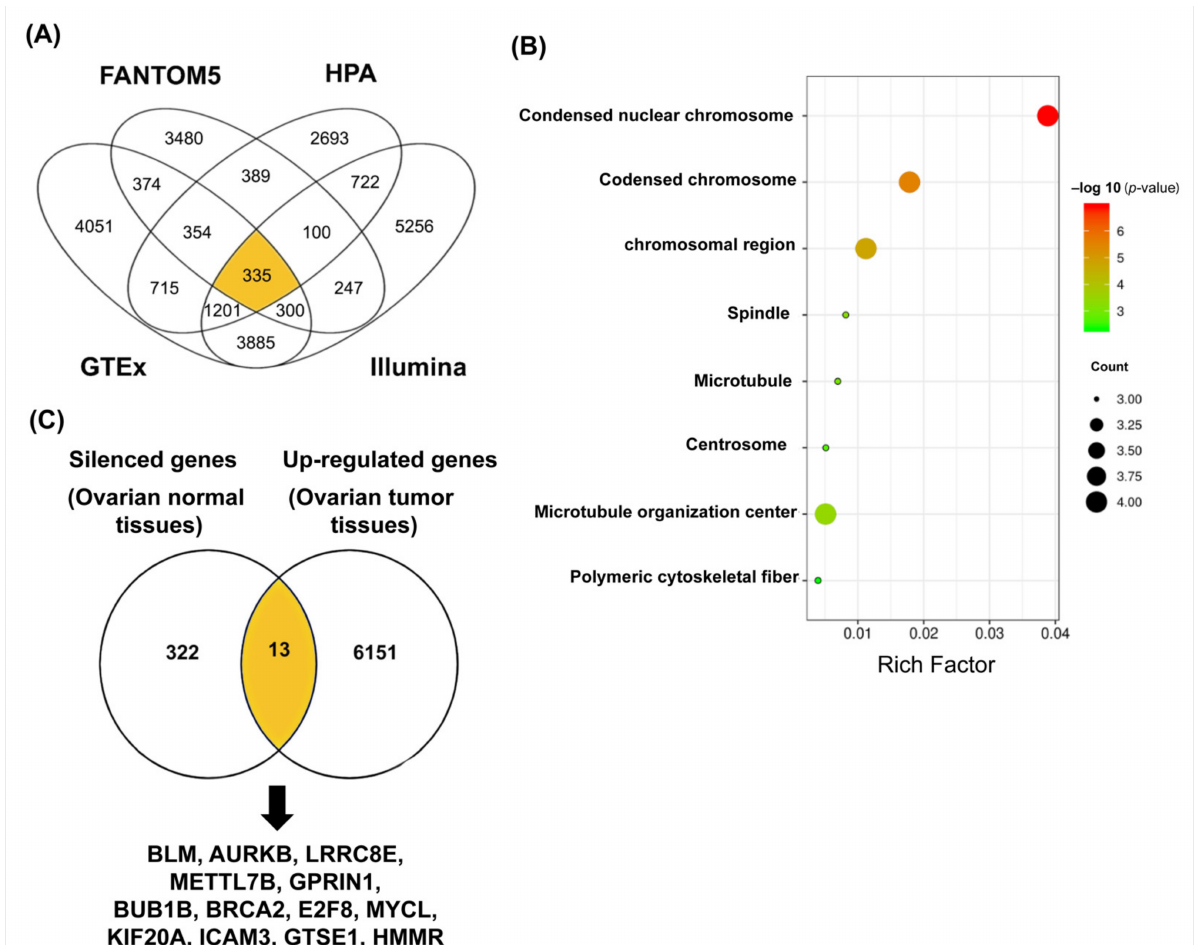
Figure 1. Identification and functional characterization of DEGs in OC. ( A ) Four datasets (FANTOM5, HPA, GTEx, and Illumina Body Map) were used to identify silenced genes in normal ovarian tissues, and the 335 overlap genes were marked by yellow in the middle; ( B ) 335 silenced genes from normal ovarian tissues (left) and 6164 up-regulated genes in OC tissues from TCGA-OV dataset (right); the 13 overlap genes were marked by yellow in the middle. These 13 common genes (DEGs) are silenced in normal ovarian tissues but up-regulated in OC tissues; ( C ) scatter plot of enriched GO pathway statistics. Rich factor is the ratio of the DEGs number to the total gene numbers in a certain pathway. The color and size of the dots represent the range of p -value (hypergeometric test and Benjamini–Hochberg methods) and the number of DEGs mapped to the indicated pathways. Top 10 enriched pathways are showed in the